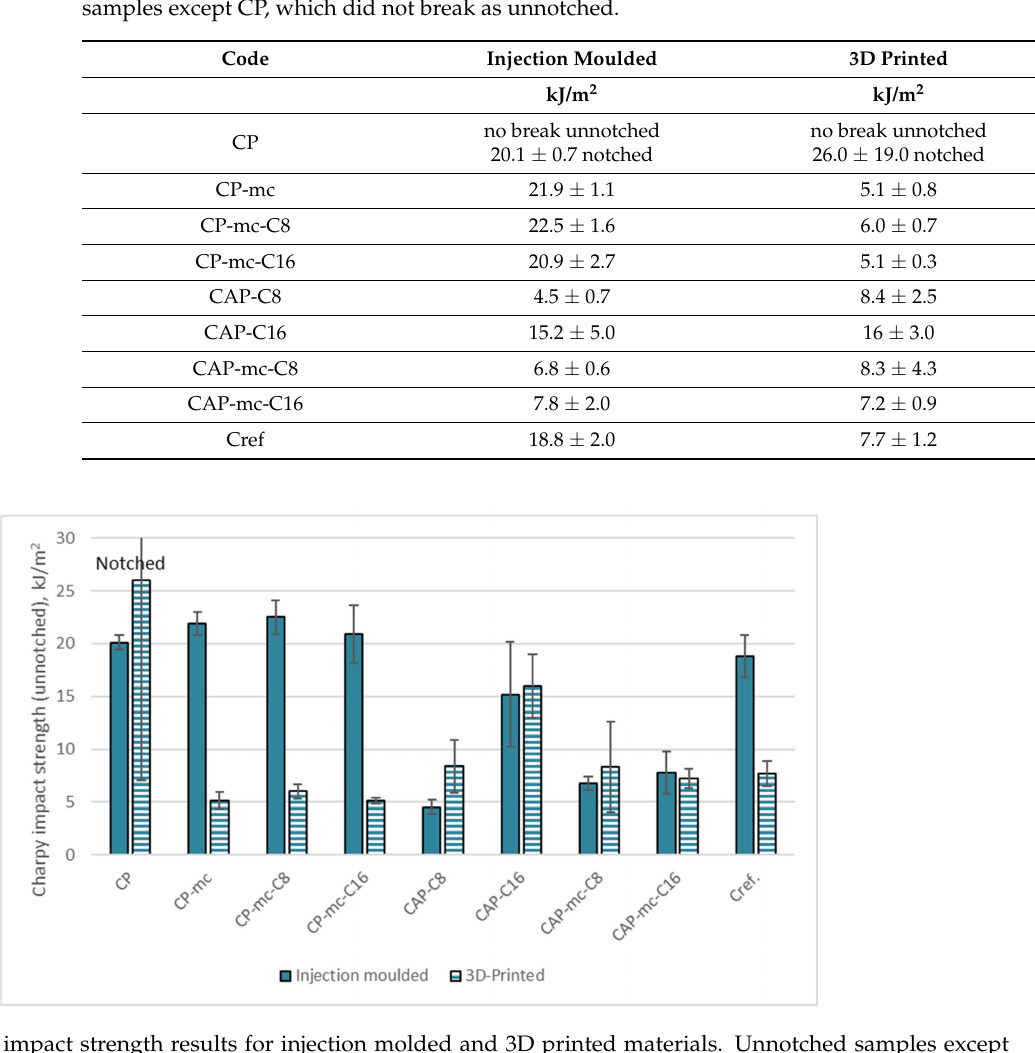
Table 6. Charpy impact strength results for injection molded and 3D printed materials. Unnotched samples except CP, which did not break as unnotched.